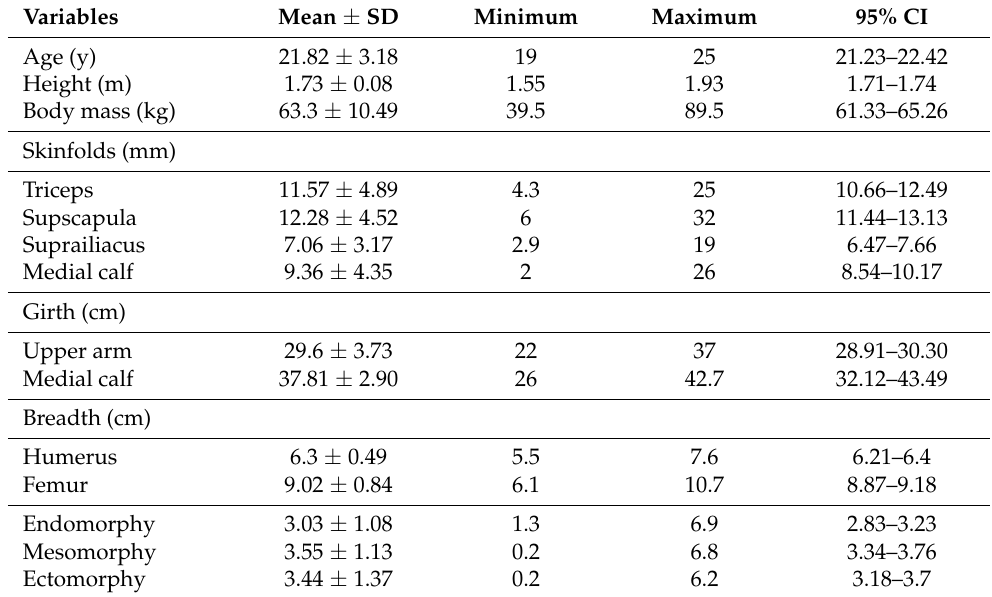
Table 1. Descriptive statistics (mean ± SD; 95% CI) for the demographic variables and somatotype components in young adults (n = 112).